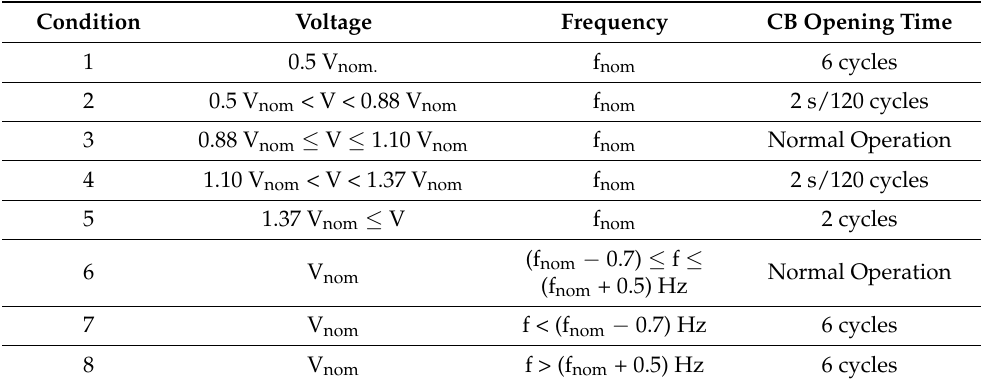
Table 7. IEEE 929–2000 requirements for DGs.